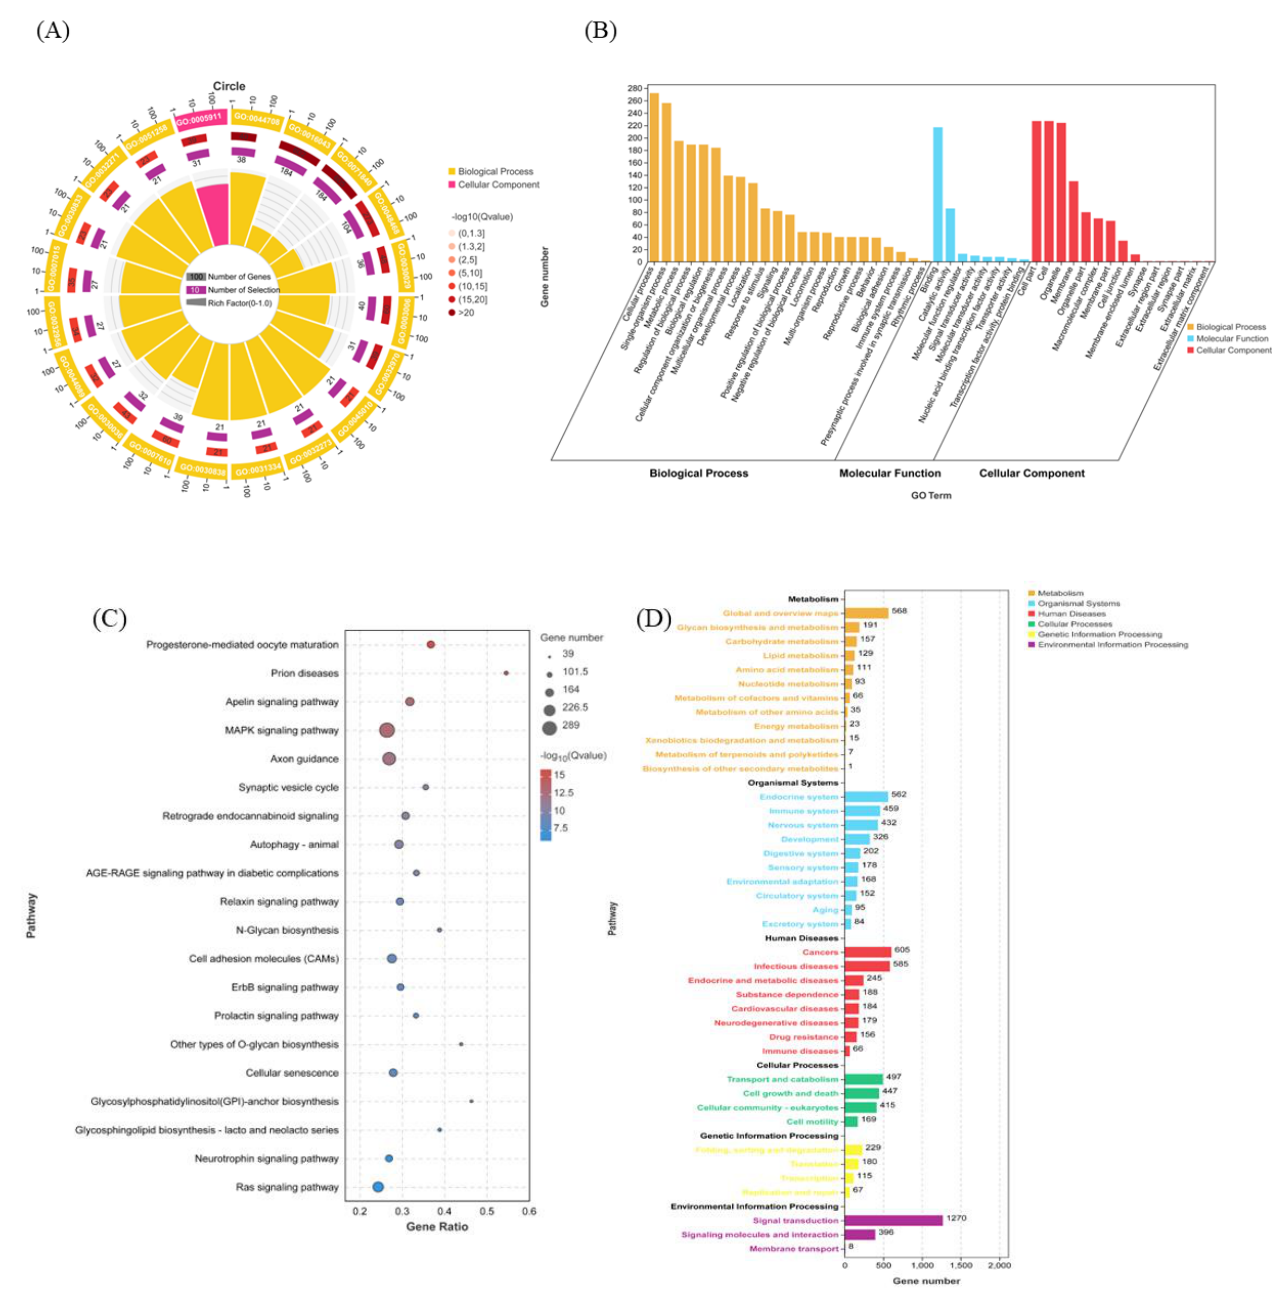
Figure 3. Functional enrichment analysis of ssc-miR-141 target gene sets. GO functional enrichment analysis of ssc-miR-141 target gene ( A , B ); KEGG pathway enrichment analysis of ssc-miR-141 target gene ( C , D ).